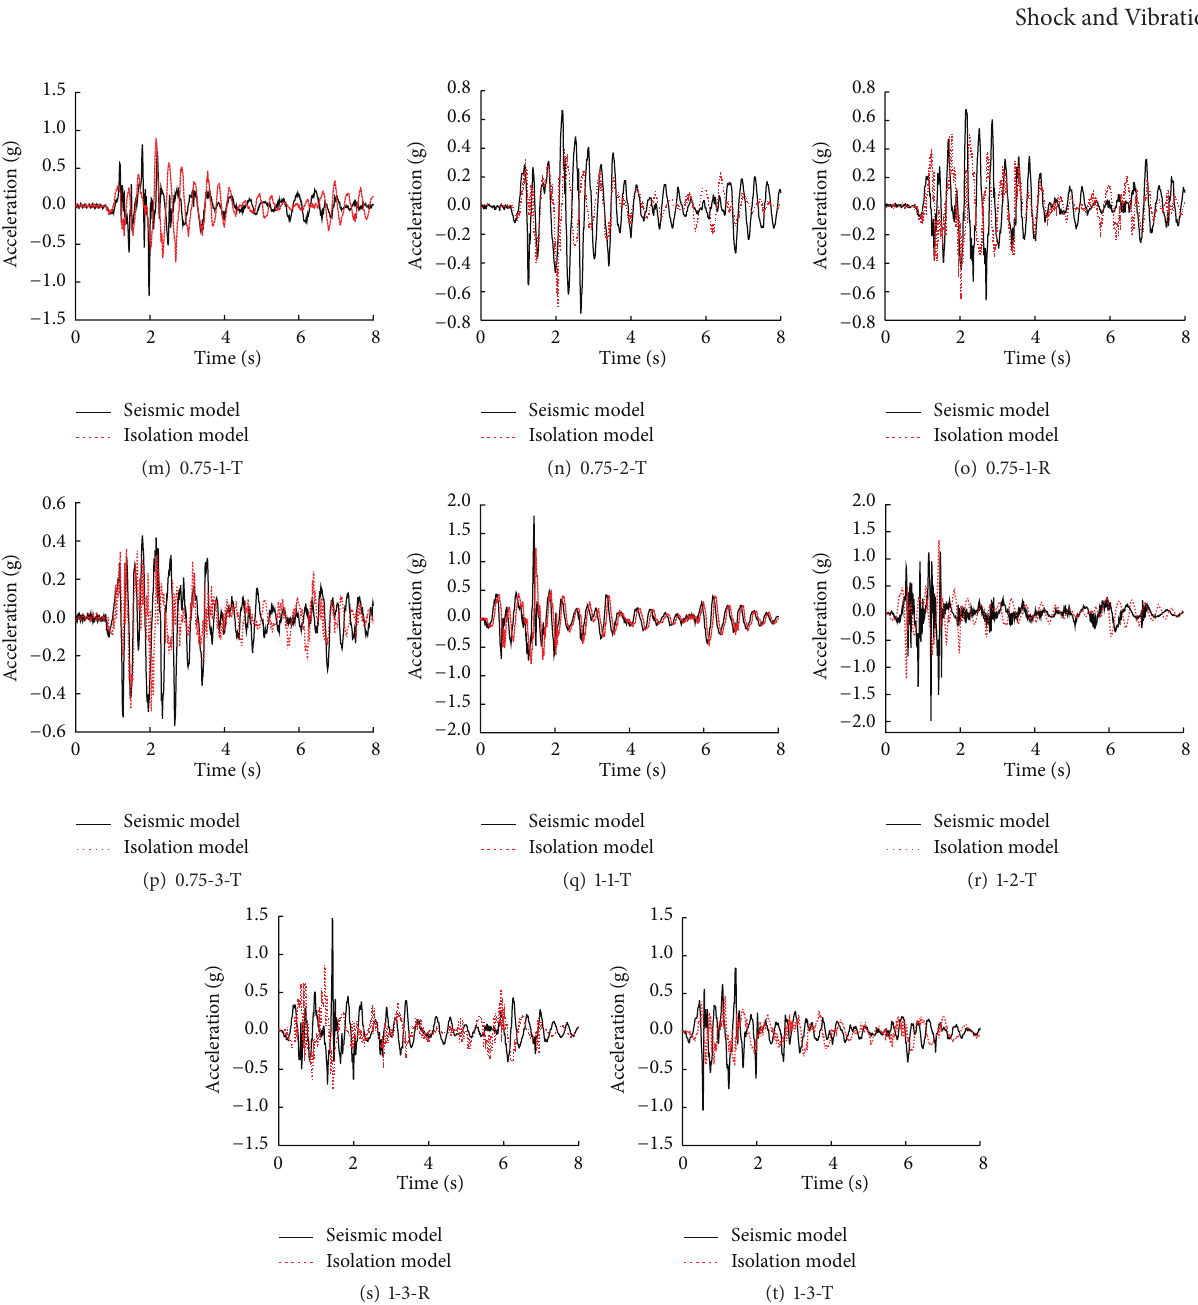
acceleration at the top of piers #1, #2, and #3 are